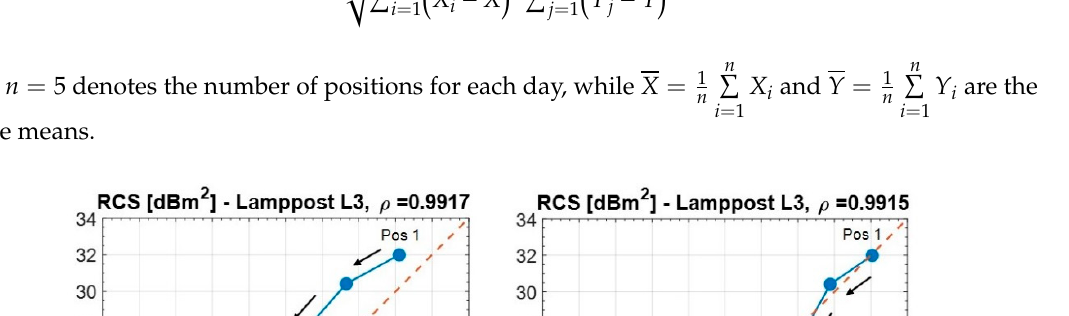
Figure 15. Comparison of the measured RCS of lampposts L1 and L2 on different days, varying the antenna position. Starting from the maximum antenna elevation (Position 1), the arrows denote the successive positions of the antenna up to the minimum antenna elevation.